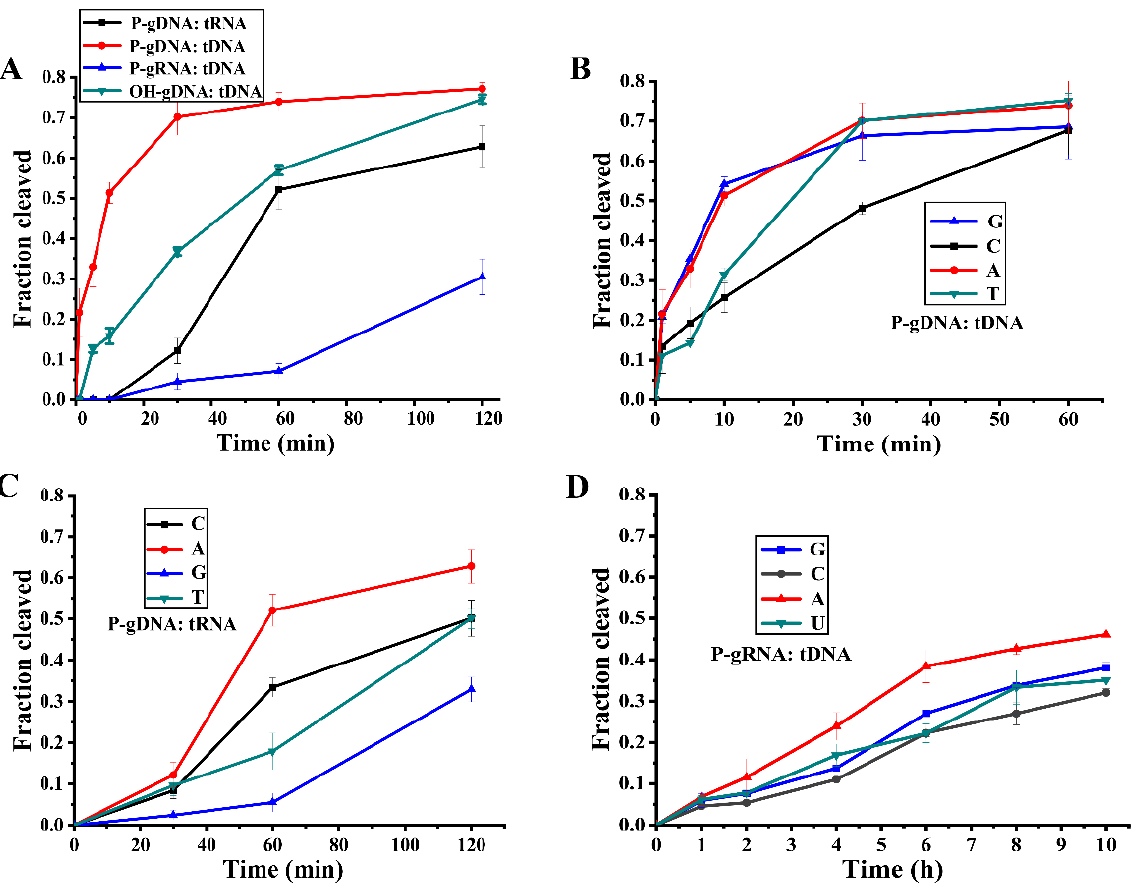
Figure 3. Effects of gDNA modification and 5 ′ -end nucleotide on RsuAgo cleavage activity. ( A ) Cleavage kinetics on DNA and RNA targets using DNA-guided and RNA-guided RsuAgo. ( B ) Cleavage kinetics on DNA target using different 5 ′ -end nucleotides of DNA guide. ( C ) Cleavage kinetics on RNA target using different 5 ′ -end nucleotides of DNA guide. ( D ) Cleavage kinetics on DNA target using different 5 ′ -end nucleotides of RNA guide. All experiments were performed at the 4:2:1 RsuAgo: guide: target molar ratio in reaction buffer containing 5 mM Mn 2+ ions at 37 °C. All cleavage experiments were carried out in triplicates and quantified. Error bars represent the SD based on three independent experiments.